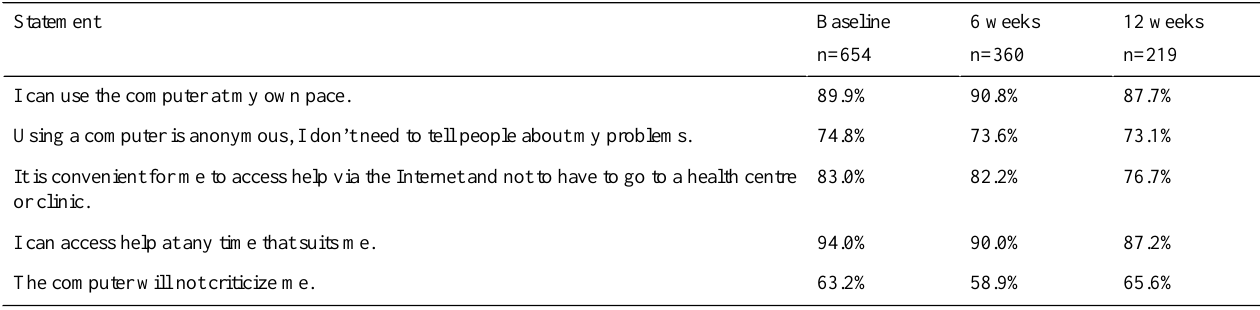
Table 2. Percentage of participants rating features “important” or “very important”.